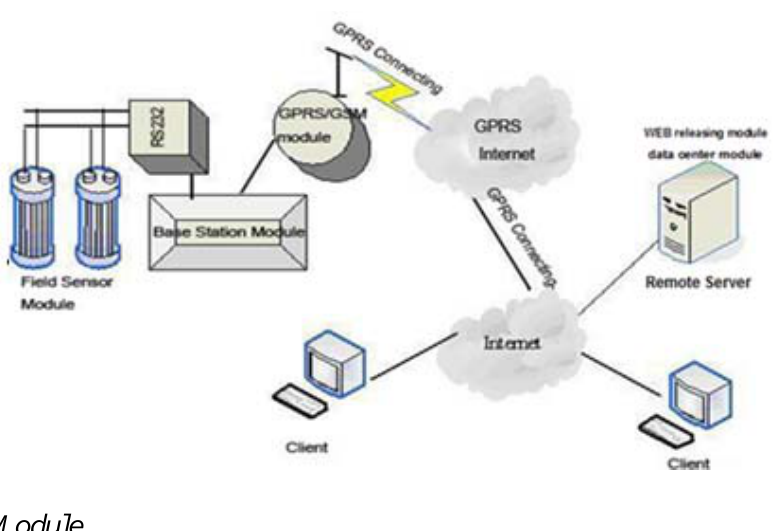
Figure 1. System structural